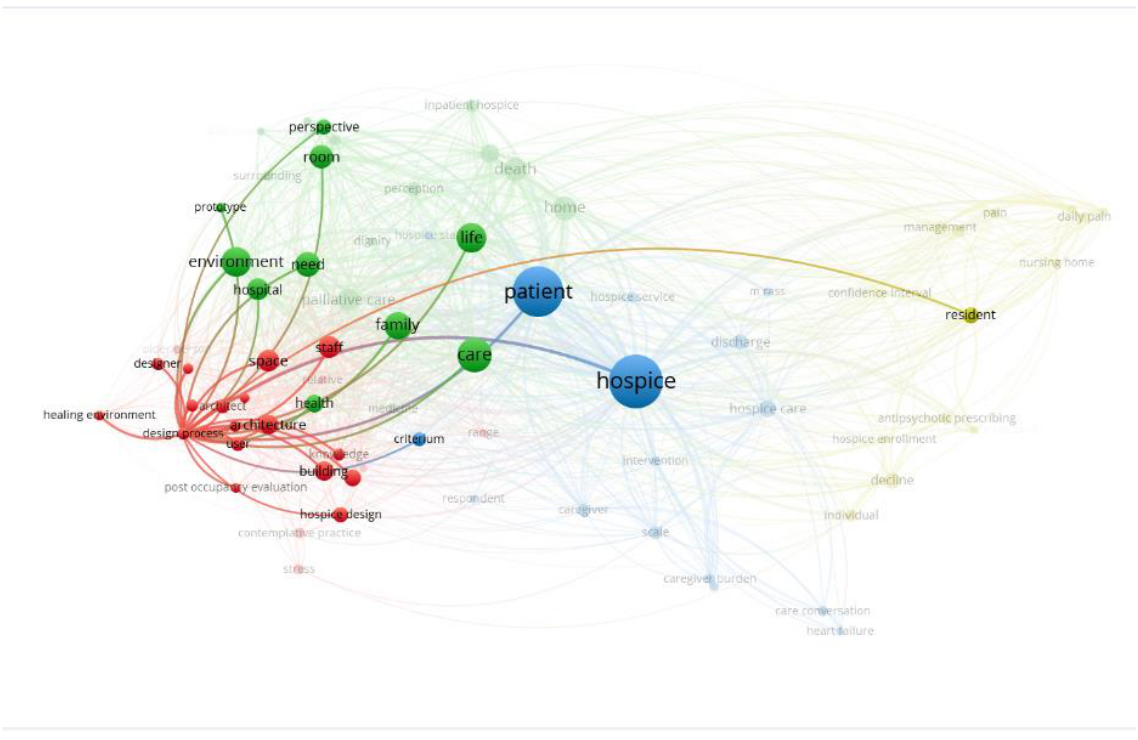
Figure 6: Map visualization showing weak links and incidence between keywords such as design process, healing environment and design in relation to hospice A desktop literature review was then carried out to determine the design standards available for these types of institutions and to build upon the findings the criteria to be added in the development of the framework, taking into consideration the elements of personalization that may be added to devise a conceptual design for areas that may aid in achieving a better quality of life for terminally ill patients through a formulation of an interview questionnaire tailored for each